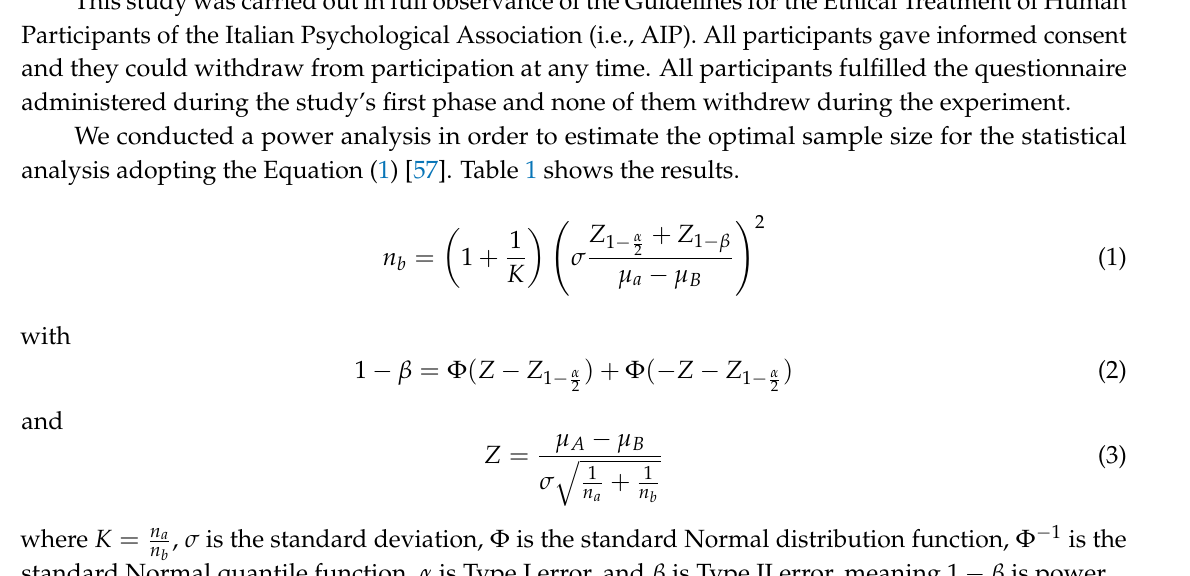
Table 1. Sample size estimation to compare two means from two samples with two sided